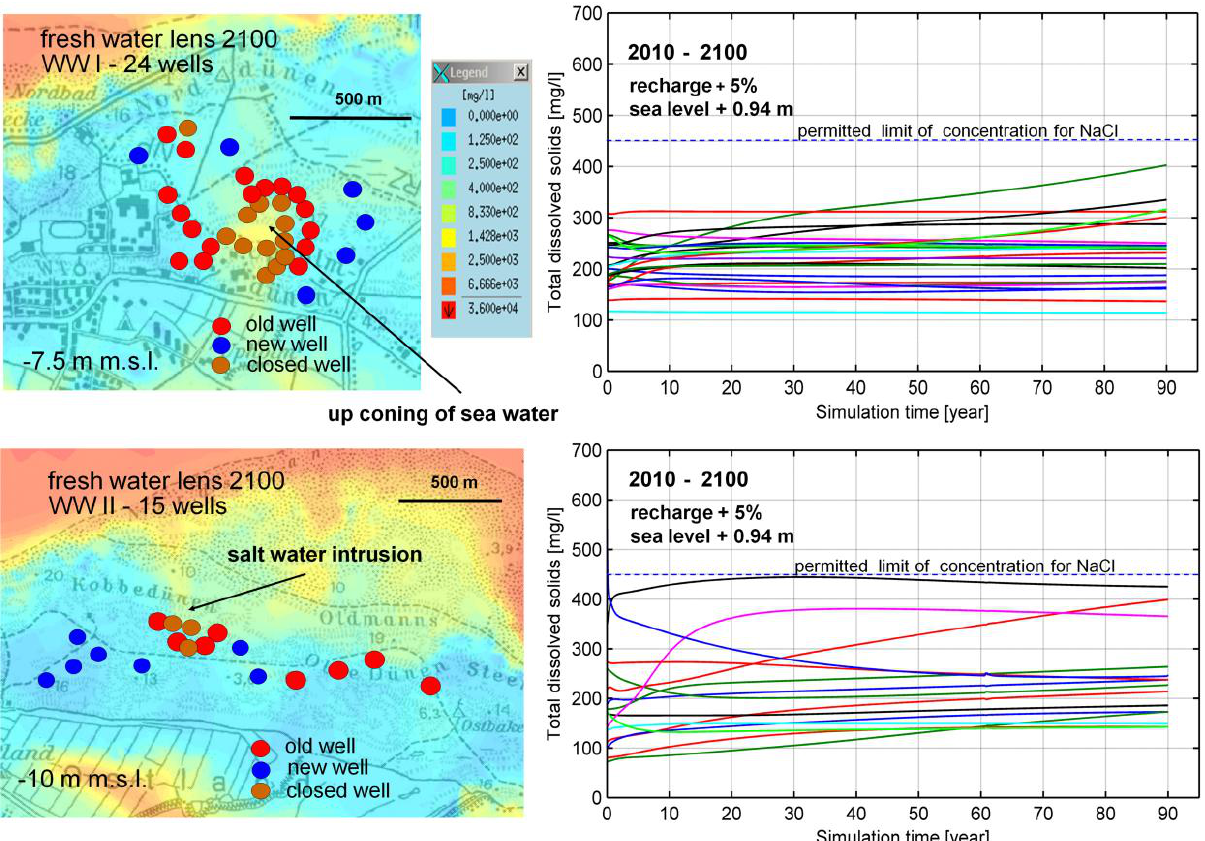
Fig. 21. Spreading of well fields as protection measure from excessive salinisation of the water supply. Location of old wells, new wells and Figure 21. Spreading of well fields as protection measure from excessive salinization of the 2 closed wells (left panel); the deep screens of WW II (Fig. 14, bottom right panel) were also closed. Development of TDS concentration in the supply wells with time (right panel). WW I Waterdelle (top panel), WW II Ostland (below water supply. Location of old wells, new wells and closed wells (left panel), development of 3 TDS concentration in the supply wells with time (right). WW I Waterdelle (top panel), WW II 4 Ostland (below panel). 5